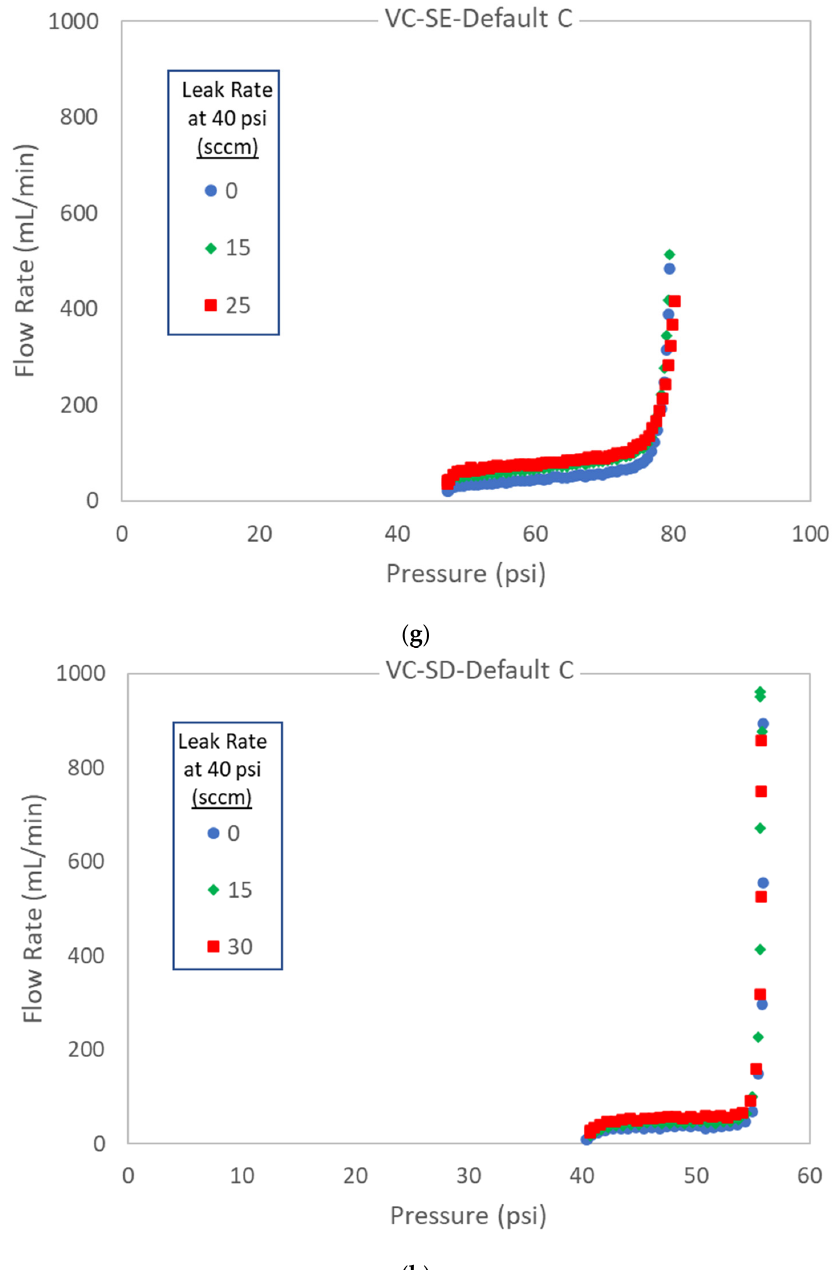
Figure A1. Effect of leak rate on bubble point curves: ( a ) vendor A, SE membrane, default A1 recipe; ( b ) vendor A, SD membrane, default A1 recipe; ( c ) vendor A, SE membrane, default A2 recipe; ( d ) vendor A, SD membrane, default A2 recipe; ( e ) vendor B, SE membrane, default B recipe; ( f ) vendor B, SD membrane, default B recipe; ( g ) vendor C, SE membrane, default C recipe; ( h ) vendor C, SD membrane, default C recipe.